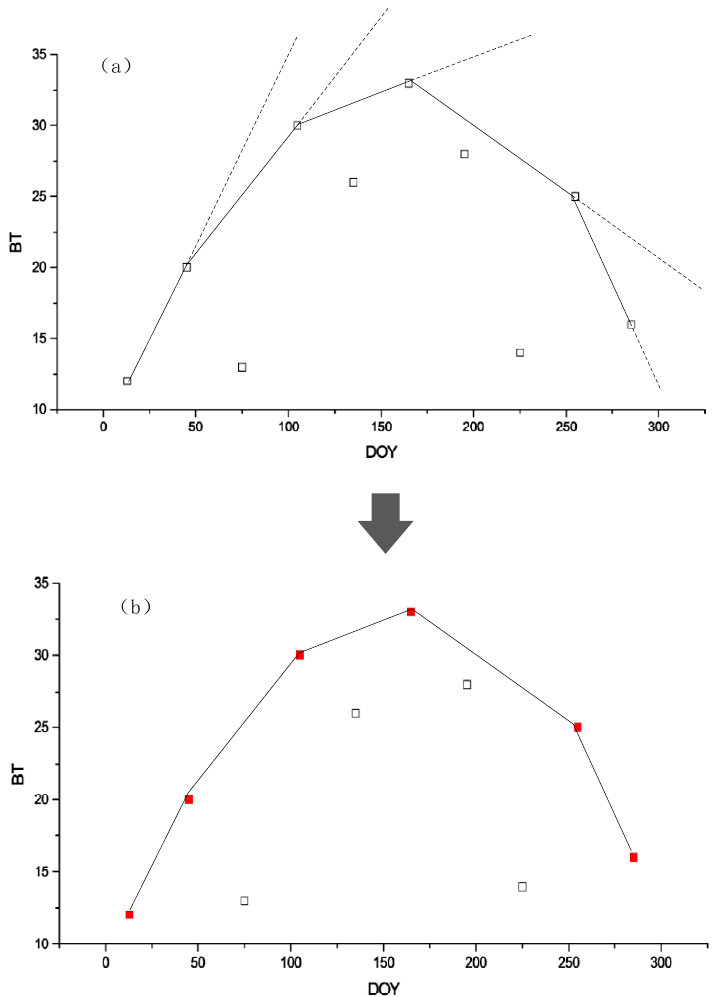
Figure A2. Calculation process of envelope of bright temperature (EBT). ( a ) Process of EBT calculation; ( b ) Results of EBT